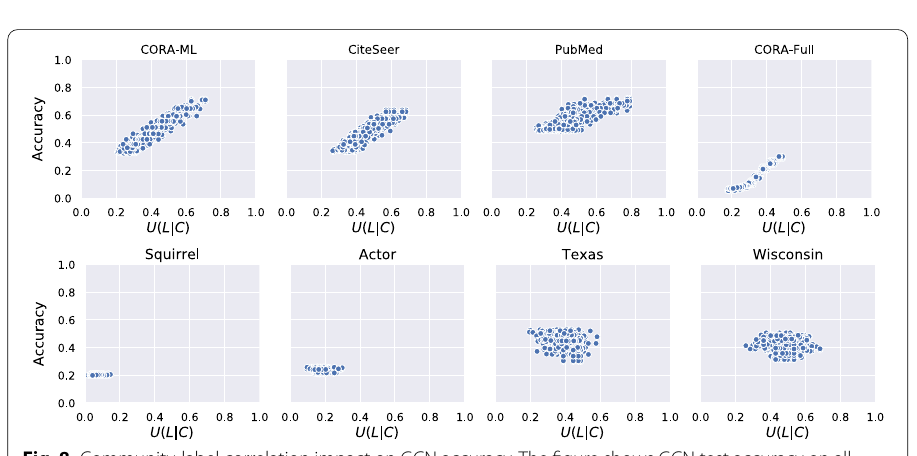
Fig. 8 Community-label correlation impact on GCN accuracy. The figure shows GCN test accuracy on all eight datasets with changing ρ . Each point represents a graph, where each graph is a Mix − graph after applying swapping for a fraction of nodes with a certain random seed for swapping. We see a positive correlation between ρ and the GNN accuracy for homophilic datasets (top row), and no obvious correlation for non-homophilic datasets (bottom